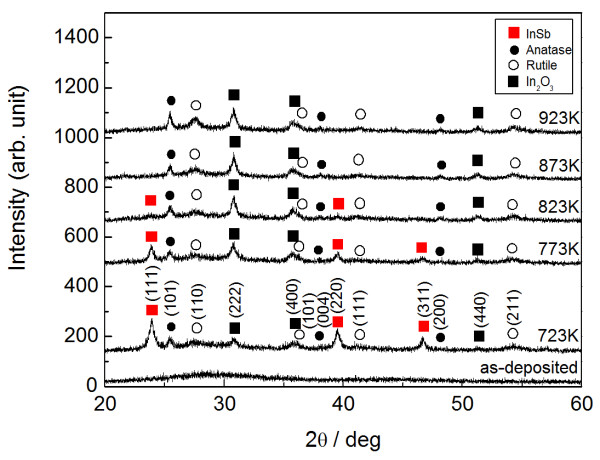
XRD pattern for InSb-added TiO2 thin films with different annealing temperatures. Red squares indicate InSb, black squares indicate In2O3, dots indicate TiO2 with anatase structure, and circles indicate TiO2 with rutile structure.